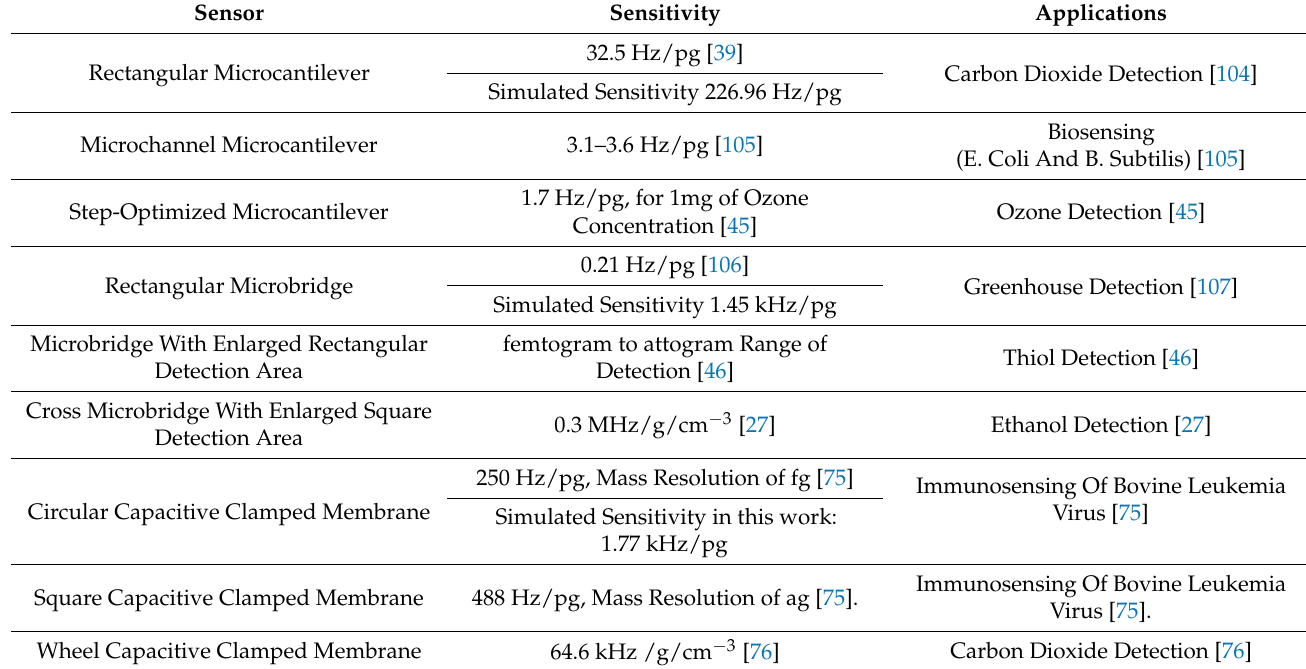
Table 2. Reported sensitivities and applications for different geometry-based mass sensors.